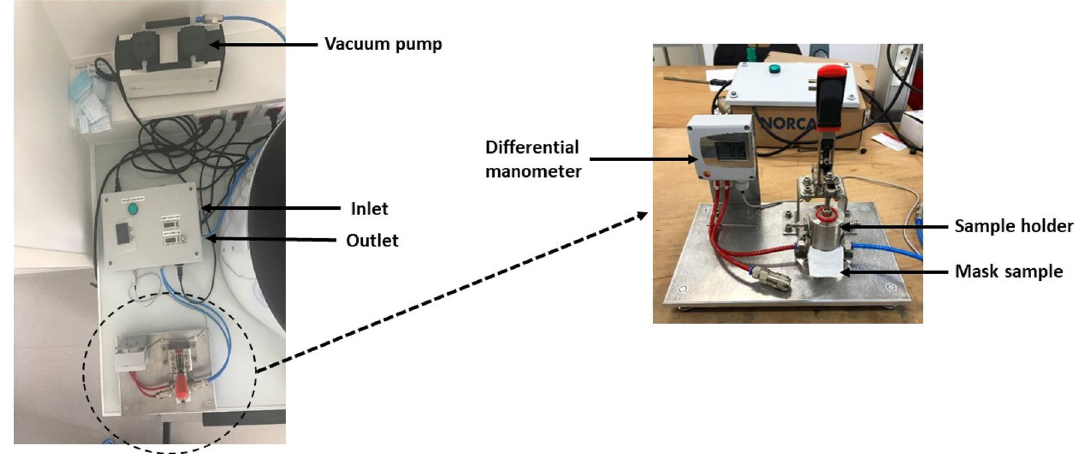
Figure 1. Experimental set-up for the evaluation of the DP compliant with the EN14683:2019 standard test